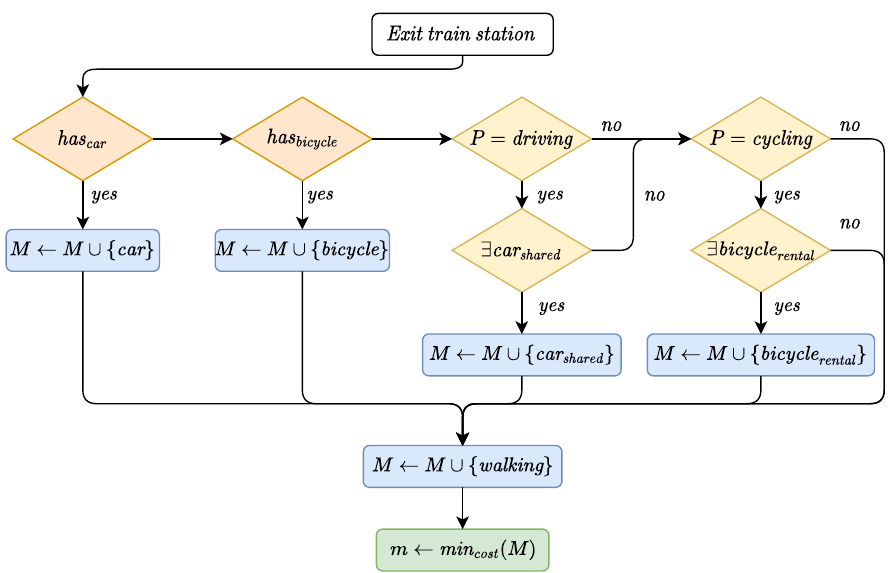
Figure 6. Selection of used modality m (green) from set of modalities M (blue) with minimal travel- time cost. M is restricted by agent’s ownership (light orange) as well as agent’s preference P and availability of shared modalities